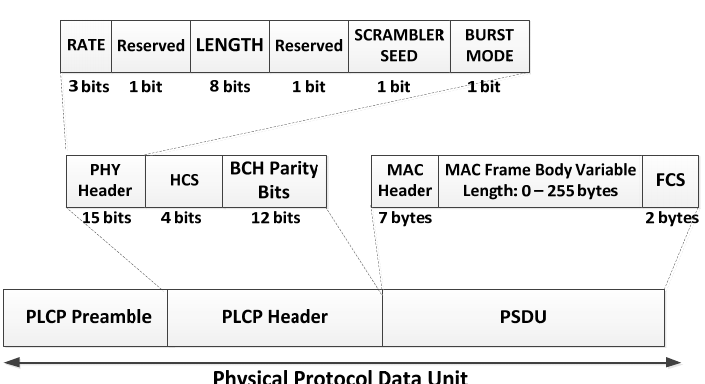
Figure 7. Physical Frame Format